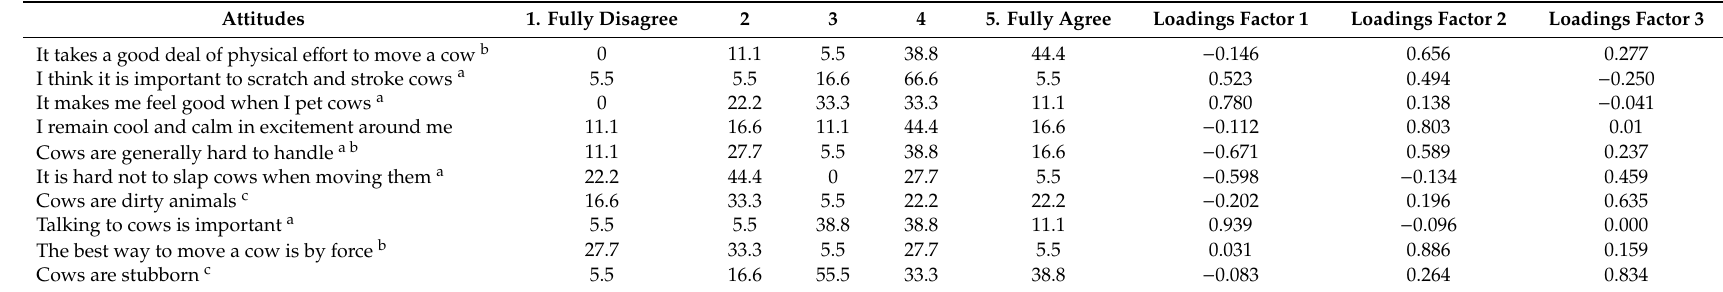
Table 1. Percentages of responses (from 1 – fully disagree to 5 – fully agree) characterizing handlers ( n = 18) attitudes toward cattle and handling behavior; and loadings of the four factors estimated by factor analysis for questionnaire data.